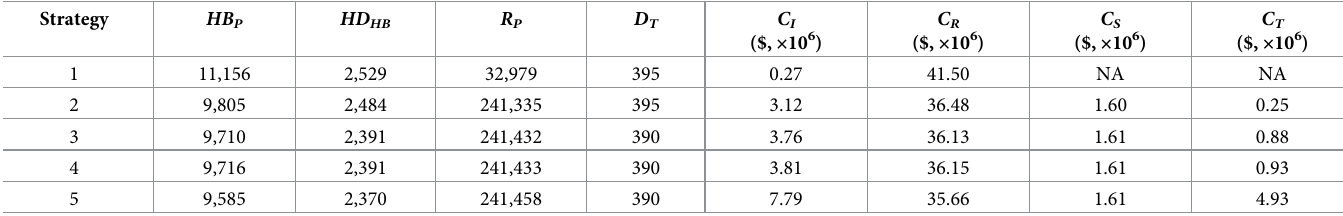
Table 7. Population stats in Acre state in 2027 under five different strategies.